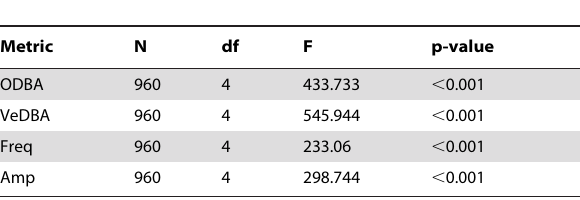
Table 1. Summary of GLM statistics for each metric comparing the relationship with speed under each substrate/ incline condition.